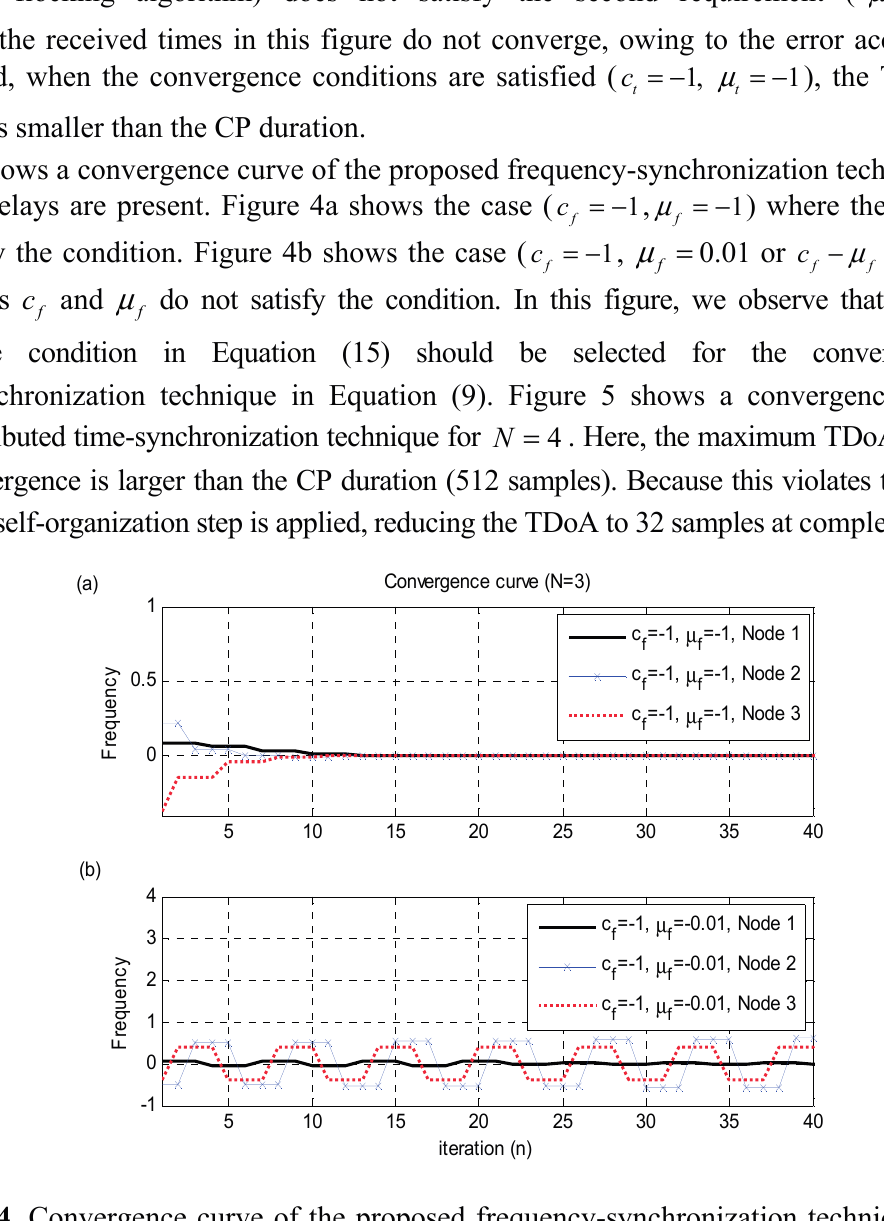
Figure 4. Convergence curve of the proposed frequency-synchronization technique when the propagation delays (